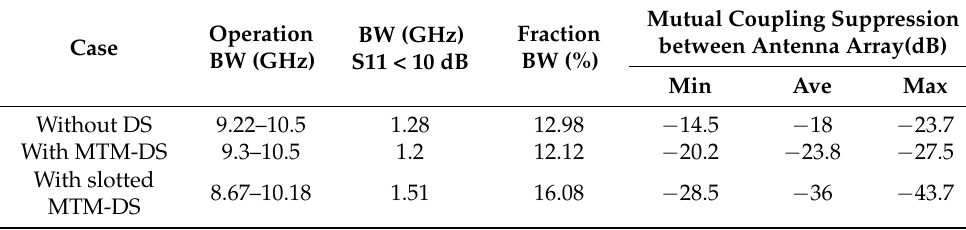
Table 2. Measurements resulted from the three isolating techniques.